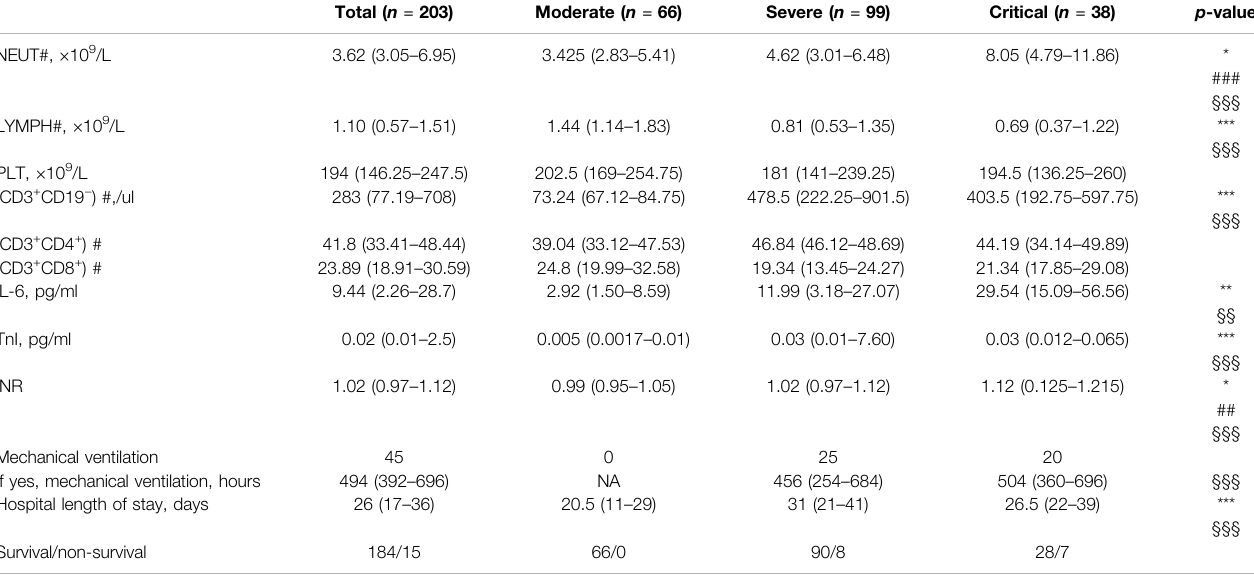
TABLE 2 | Statistical characteristics of clinical indicators in patients with